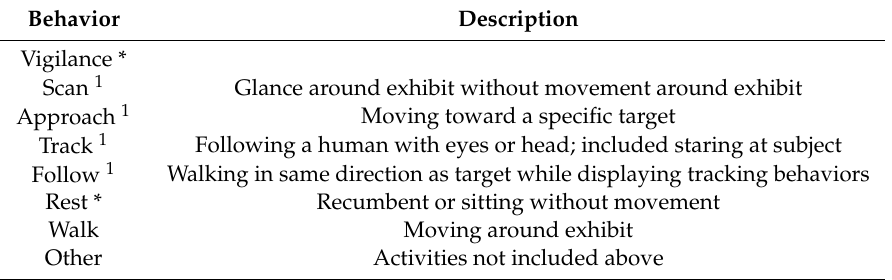
Table A3. Lion ethogram, with behaviors of focus indicated with an asterisk